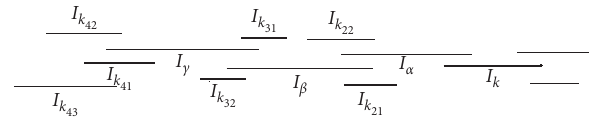
Figure 8: A set of intervals.